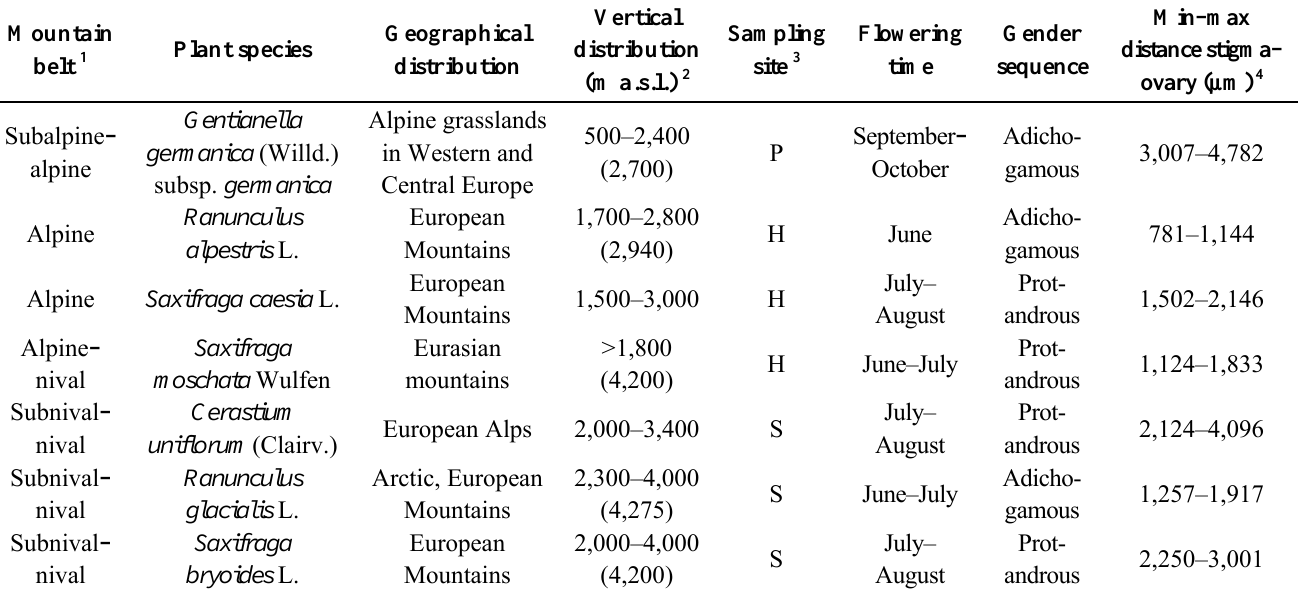
Table 1. Characteristics of the investigated